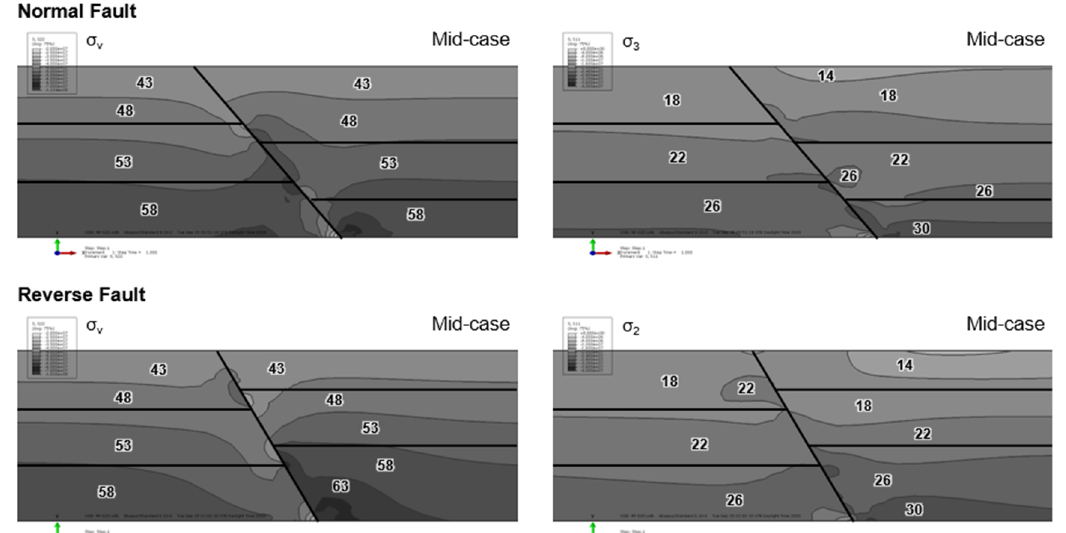
Figure 8. Contours of the effective vertical stress, σ ′ v (left) and horizontal stresses σ ′ 3 and σ ′ 2 (right) for the normal fault (upper) and the reverse fault (lower) geometries, for the mid-case scenario. Effective stress values are shown in MPa, where ranges in legends are 20–100 MPa for σ ′ v and 0–40 MPa for σ ′ 2 and σ ′ 3 .